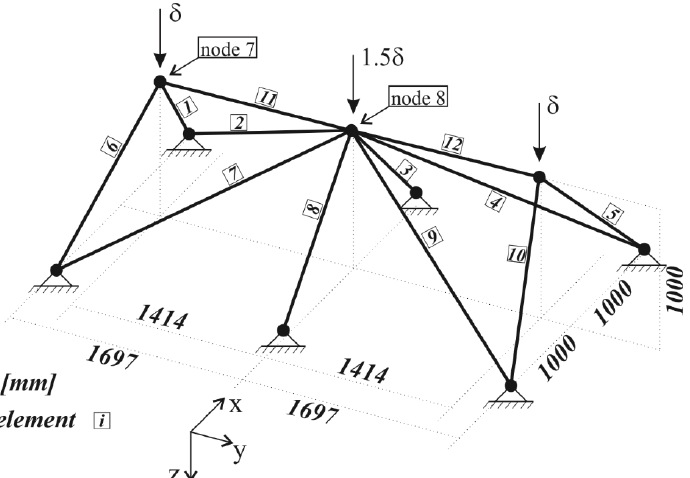
Figure 3. Geometric input data for twelve-member 3D truss.